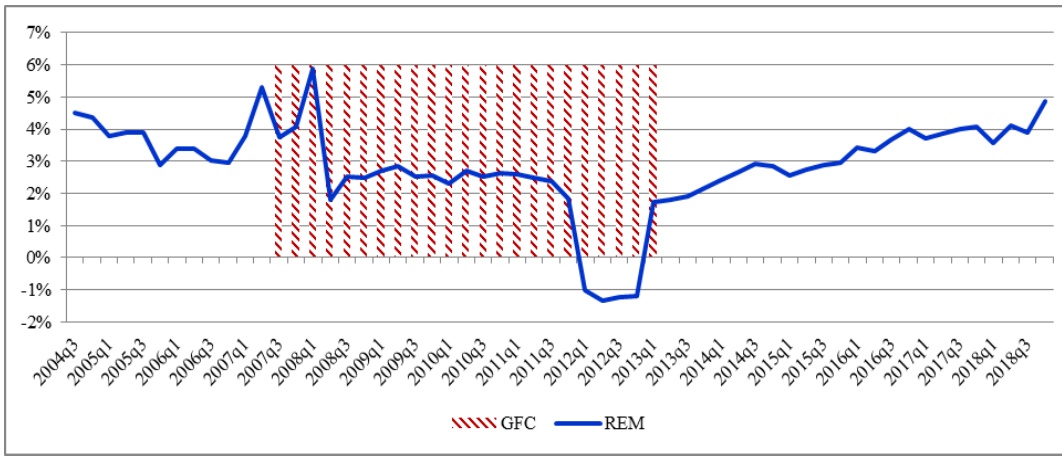
Figure 9. The global financial crisis and the REM in